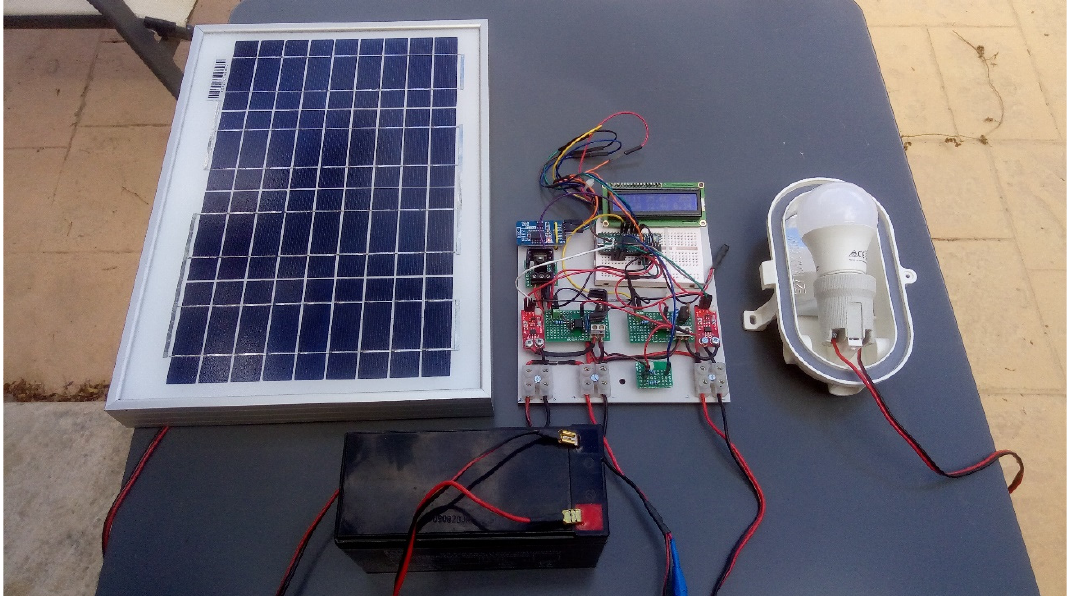
Figure 9. IoT device with integrated battery controller.